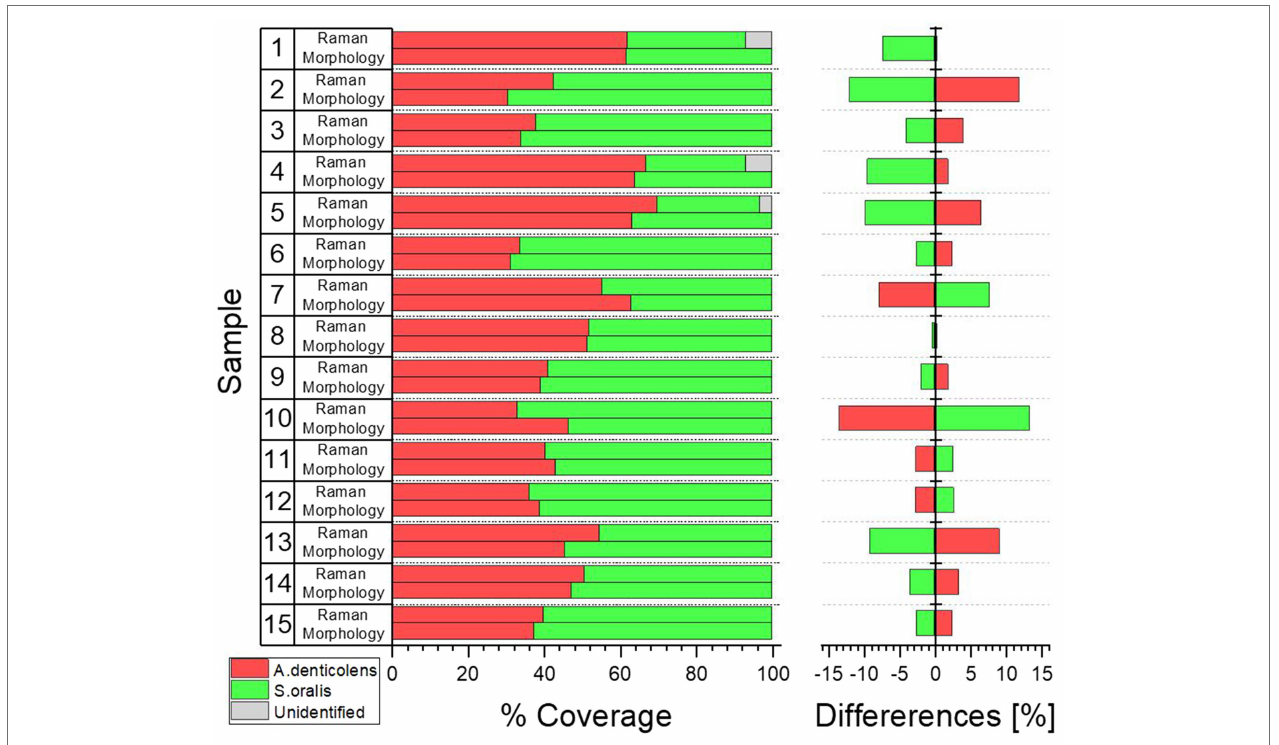
FIGURE 7 | Coverage distribution was calculated from samples shown in Figure 6 for morphology and Raman analysis using ImageJ. Percent difference between the two analysis methods was compared considering morphology analysis as the true